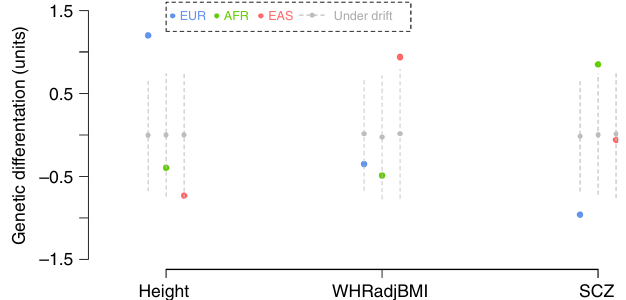
Fig. 2 Direction of genetic differentiation for height, WHRadjBMI and SCZ in the 1000G populations. The colored dot represents the estimated deviation (in s.d. units) of the mean PRS based on the trait-associated SNPs clumped at P < 5 ´ 10 (cid:2) 6 of a population from the overall mean across populations. The gray dot represents the mean of mean PRS values of 10,000 sets of control SNPs, with the gray dashed line indicating the 95% con fi dence interval of the distribution of mean PRS values. WHRadjBMI, waist-to-hip ratio adjusted by BMI; SCZ schizophrenia, EUR European,